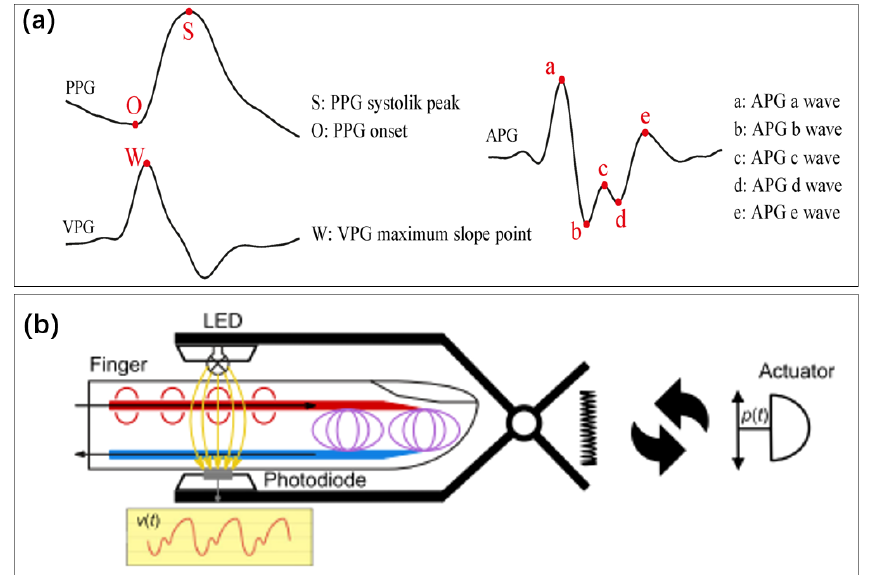
Figure 14. ( a ) Graphical definition of fiducial points detected from photoplethysmogram (PPG), velocity plethysmogram (VPG), and acceleration plethysmogram (APG) signals [188]. Reproduced under the terms of the CC- BY Creative Commons Attribution License, Copyright 2022 by the au- thors, published by MDPI. ( b ) Optical sensor for detecting blood flow in fingers [189]. Reproduced under the terms of the CC- BY Creative Commons Attribution License, Copyright 2021 by the au- thors, published by Springer Nature.